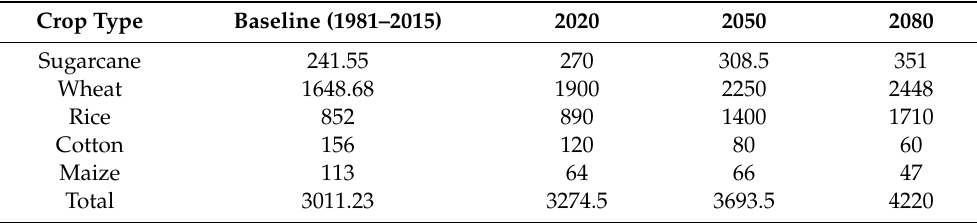
Table 5. Future changes in agriculture crop sown area of five major crops (unit: 1000 ha). Crop